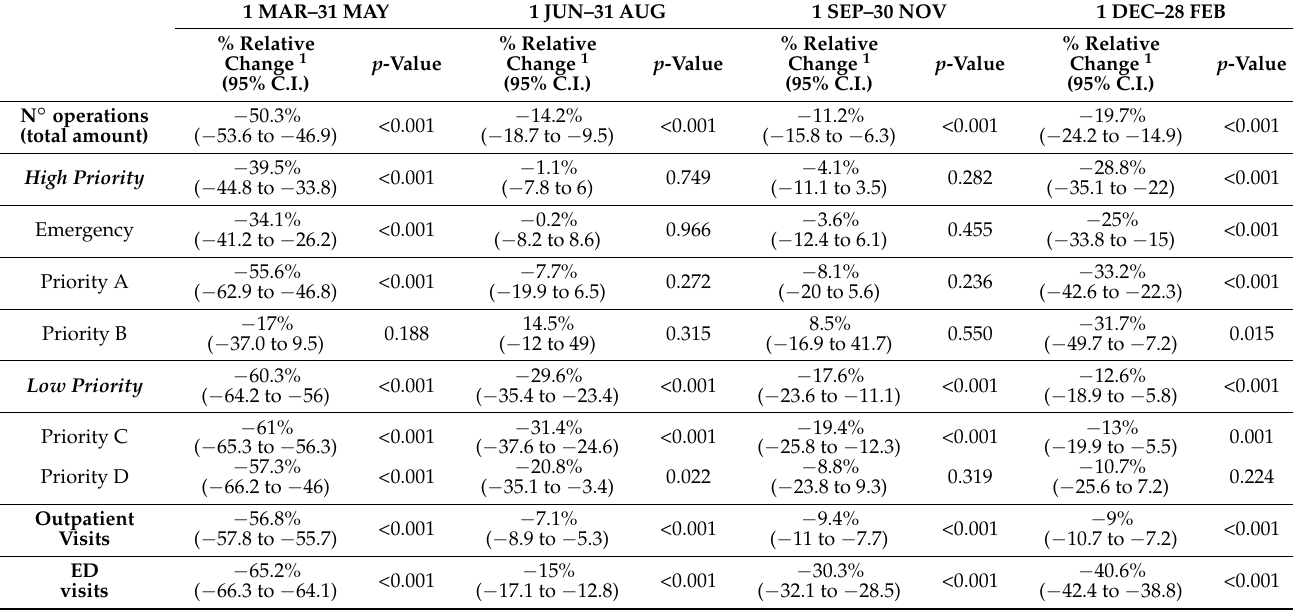
Figure 1. Graph illustrating the trend of surgical volumes in pediatric orthopedics during the period March 2018–February 2021, in relation to the pandemic situation in Italy. Table 3. Relative change in medical and surgical volumes, during the year of COVID-19, divided by Table 2. Medical and surgical volumes in pediatric orthopedics and traumatology during the 2018–2020 period.